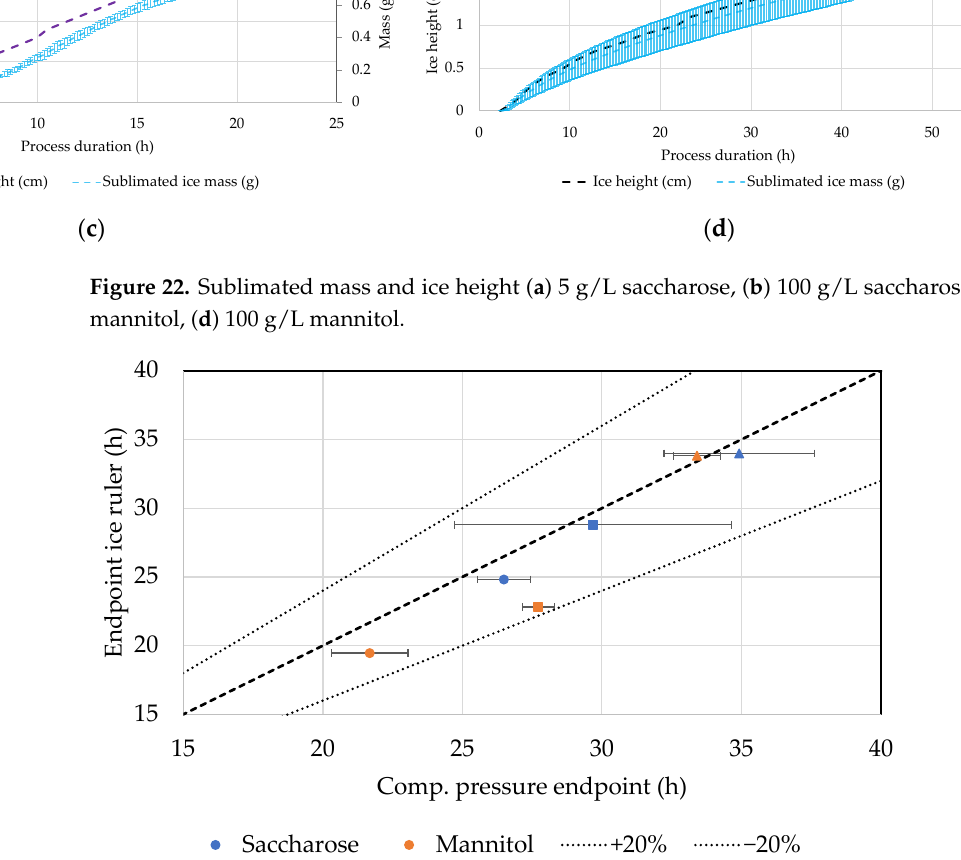
Figure 22. Sublimated mass and ice height ( a ) 5 g/L saccharose, ( b ) 100 g/L saccharose, ( c ) 5 g/L mannitol, ( d ) 100 g/L mannitol.